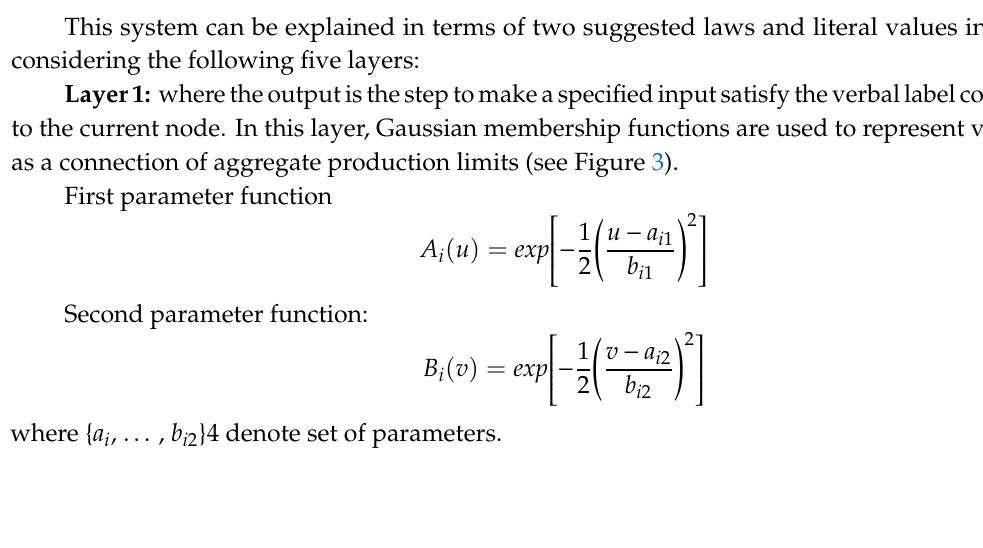
Figure 2. Adaptive Neuro-Fuzzy Interference System ( ANFIS ) network for a two-input ‘Sugeno’ fuzzy model.